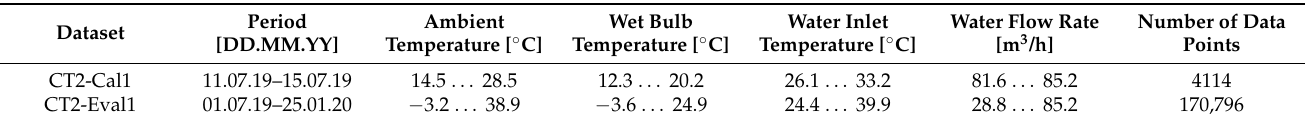
Table 6. Overview over the datasets of CT2 used for model calibration and evaluation; ranges are marked with “MIN . . . MAX”. Period Dataset